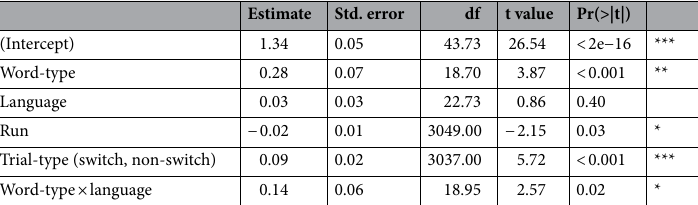
Estimate Std. error